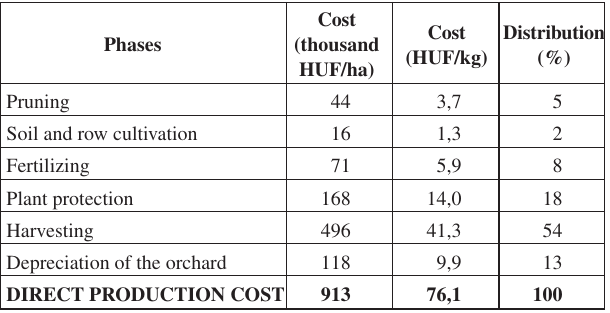
Table 1. The costs of sour cherry production by working phases (per hectare)